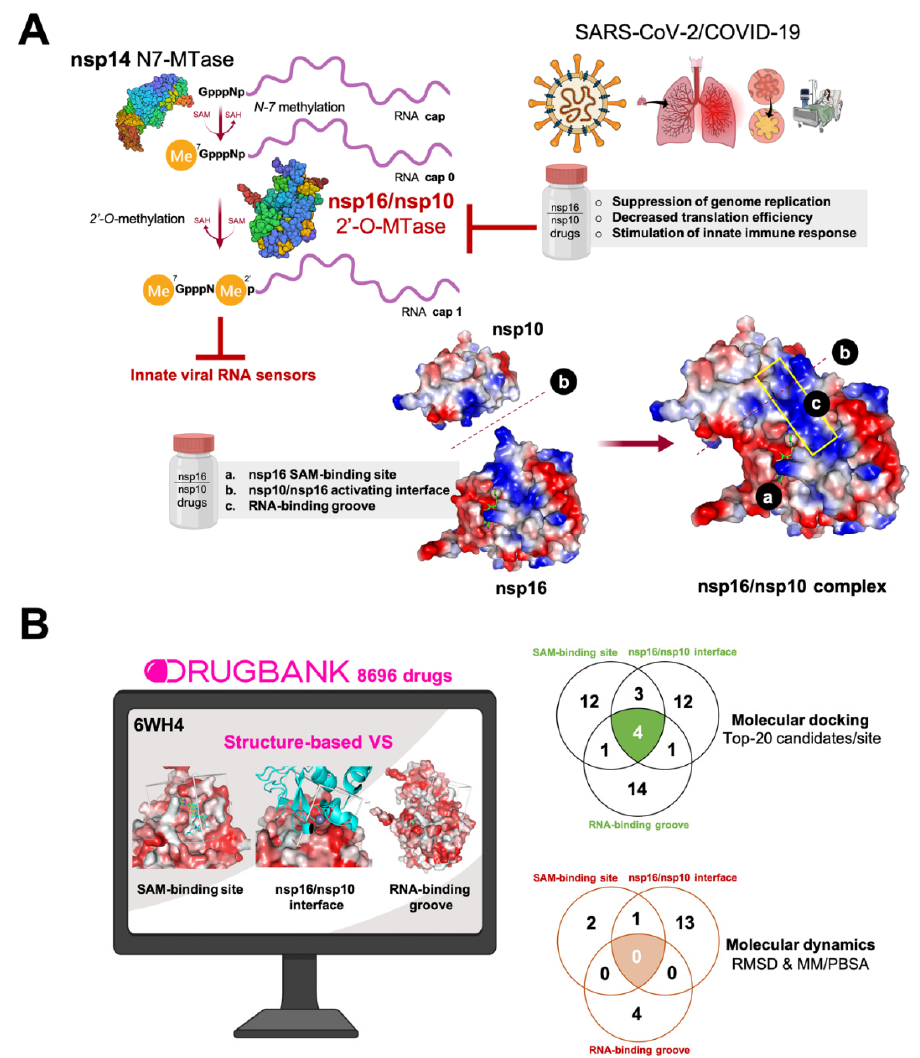
Figure 1. ( A ) Therapeutic relevance of targeting the nsp16/nsp10 2 ′ -O-methyltransferase (2 ′ -O- MTase) protein complex. Severe acute respiratory syndrome coronavirus-2 (SARS-CoV-2) encodes